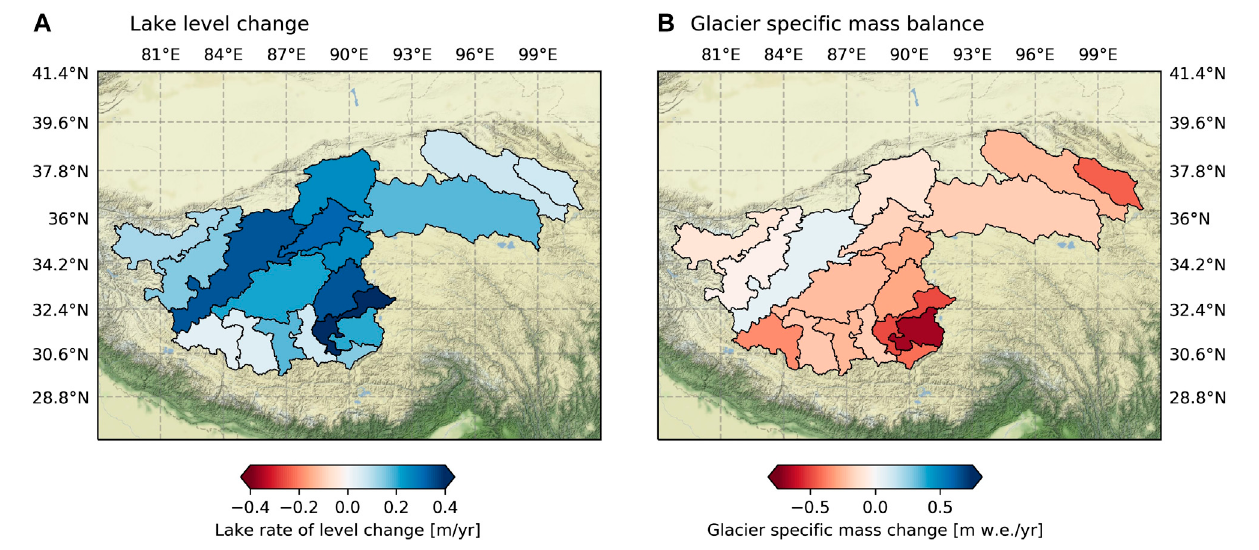
FIGURE 3 | Lake level change rate (A) and speci fi c glacier mass balance (B)